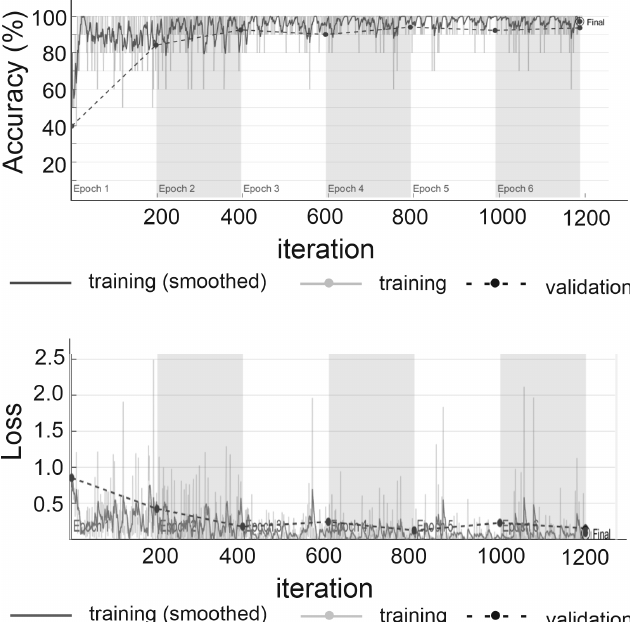
Figure 6. Accuracy and loss function variability depending on the number of iterations obtained during ResNet-50 training using the interferometric data set.